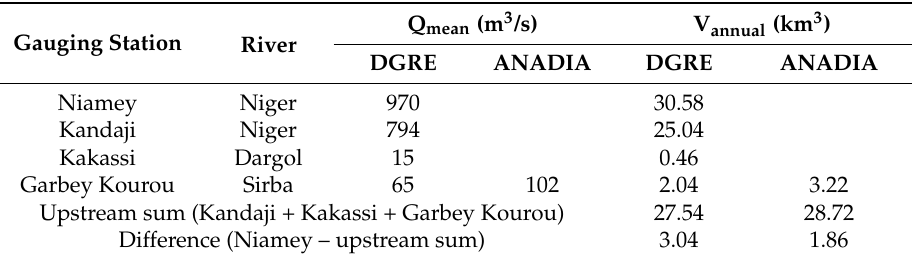
Table 4. Mean discharge and mean annual volume for the different gauging stations over the period of 2007–2017.